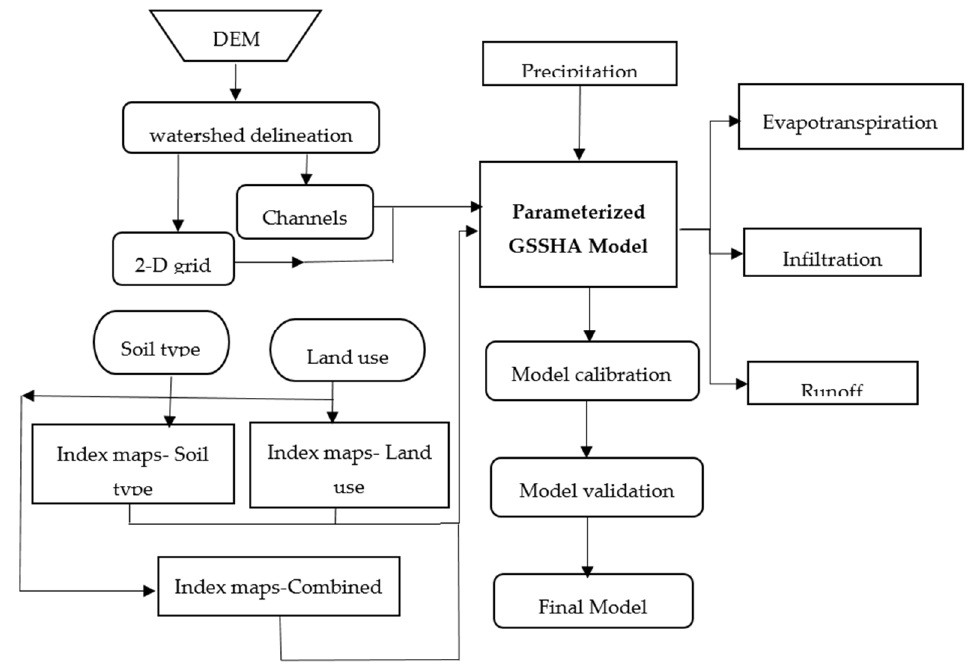
Figure 5. Flowchart of the GSSHA model setup process.